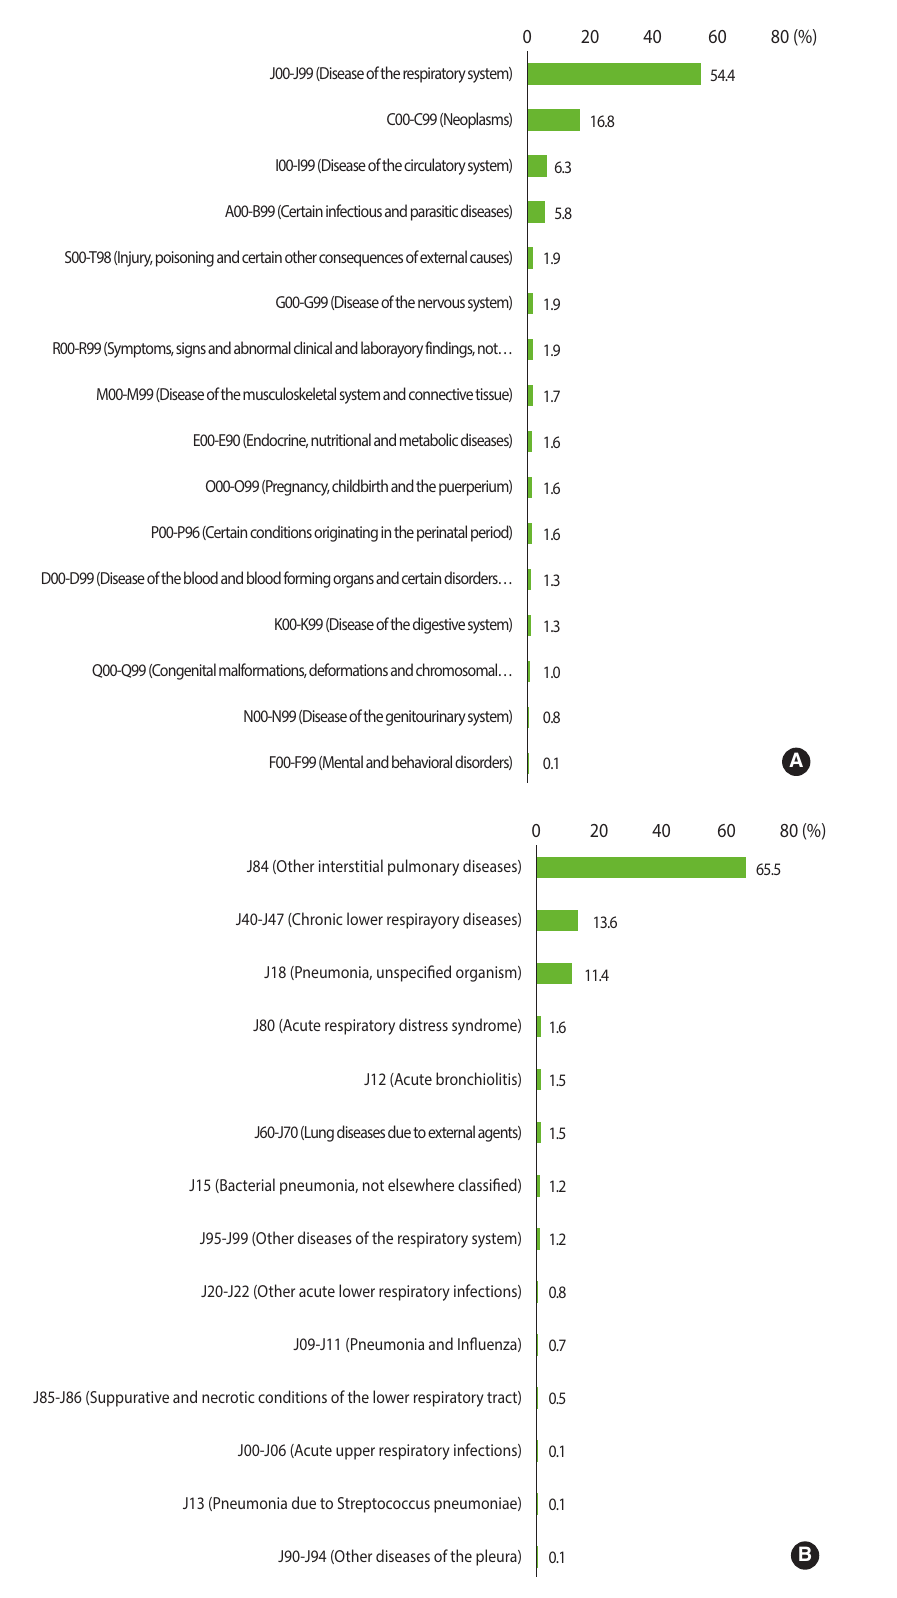
Figure 3. Distribution of all causes of death (A) and distribution of causes of death due to respiratory diseases (J00-J99)